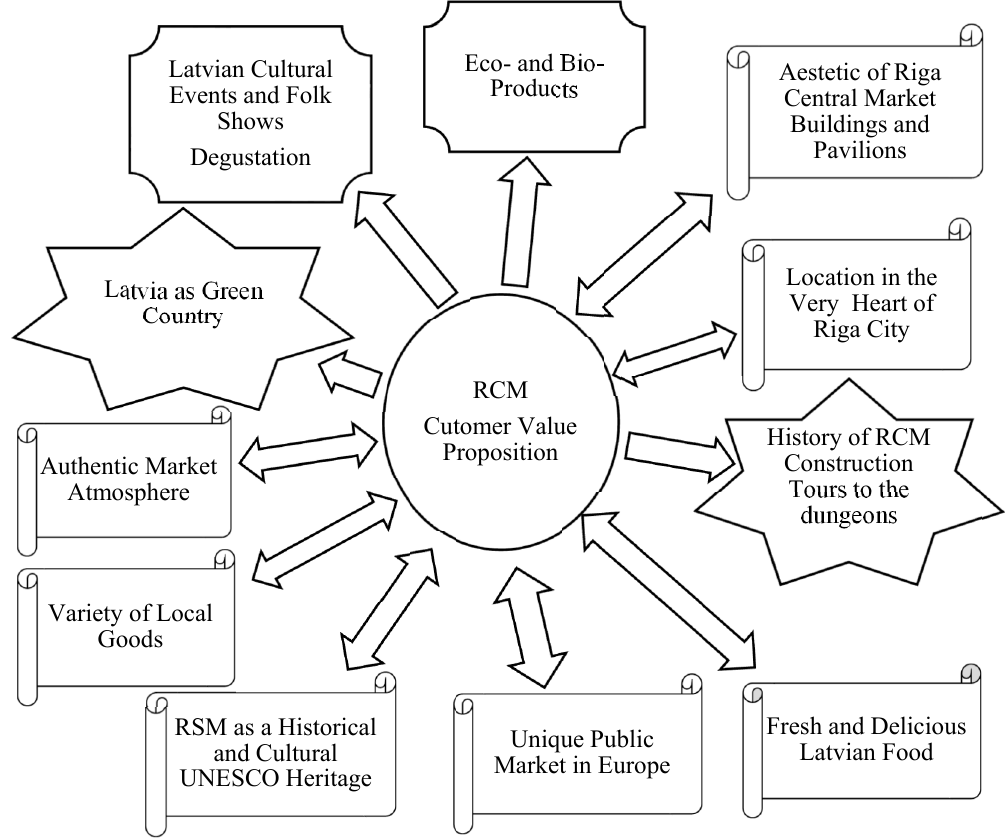
Figure 4. Designing organizational eco-map of to develop new CVP of RCM. Source: developed by the author.